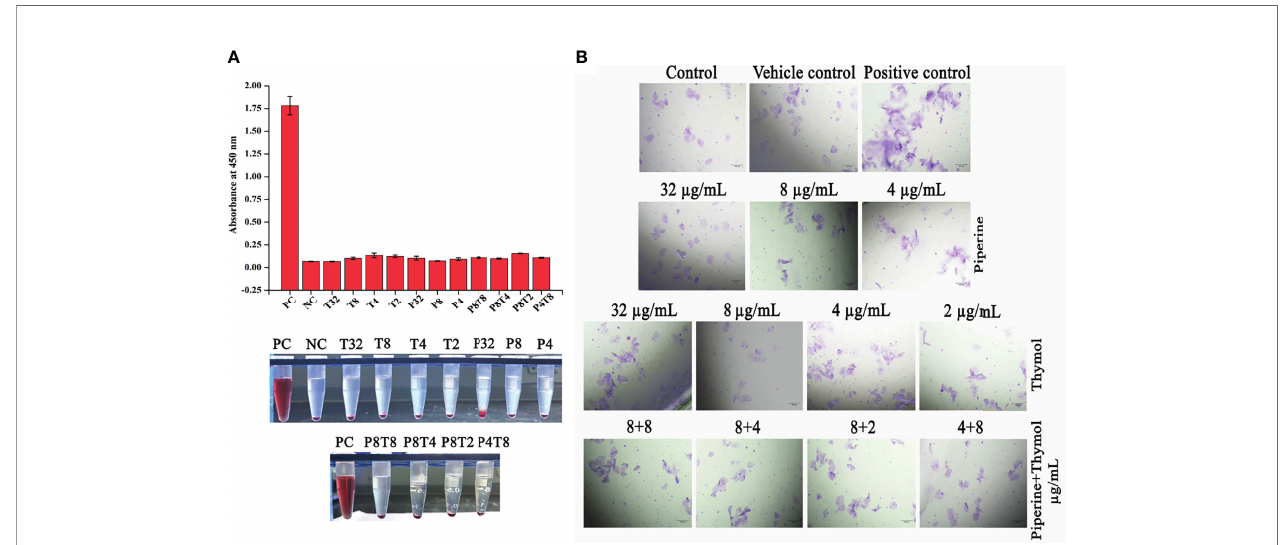
FIGURE 11 | Non-toxic nature of phytocompounds. (A) Effect of phytocompounds and their synergistic combinations on human erythrocytes. No haemolytic activity was observed. As no haemolysis was observed, the graph was plotted with absorbance. Positive control Triton X-100 completely lysed the erythrocytes. (B) No toxic effect was observed on HBECs when treated with individual and combination of phytochemicals. Hydrogen peroxide (positive control) instigated morphological alterations in